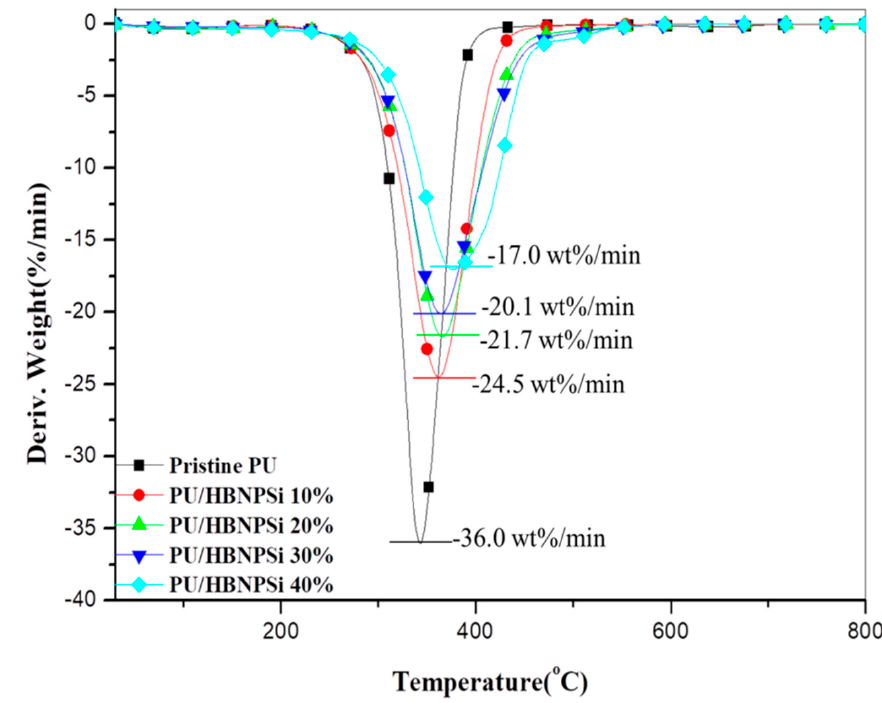
/ HBNPSi hybrid in N 2 .